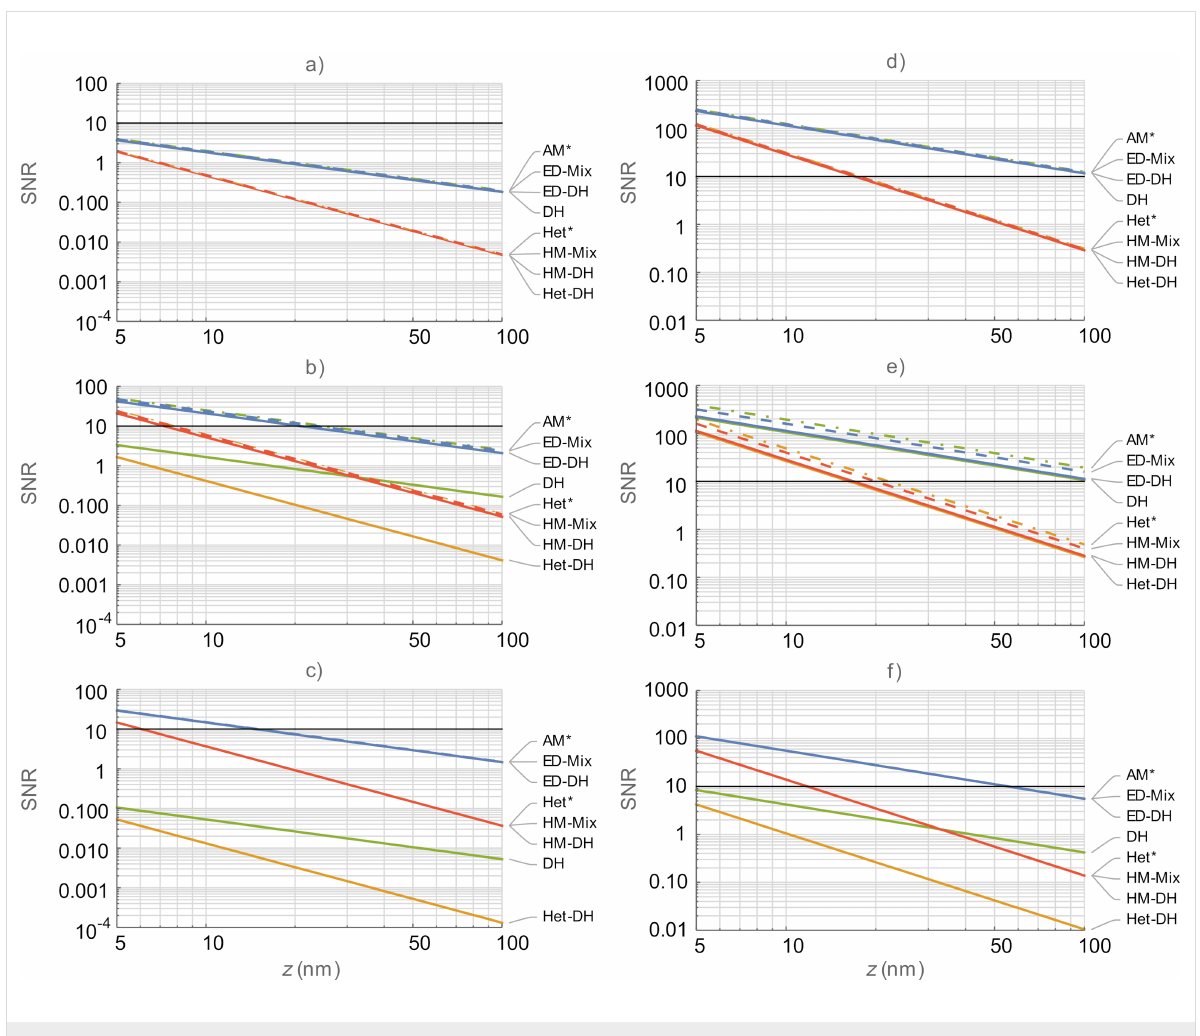
Figure 5: Comparison of SNR of KPFM modes in air (a–c) and water (d–f) for the first harmonic electrostatic response occurring on ω off (top), ω 1 (middle), and ω 2 (bottom), respectively. DH (green), Het-DH (orange), ED (blue), and HM (red). Mixed responses are shown with dashed lines. Single frequency responses are shown with dash-dotted lines. *Designated single-frequency KPFM modes. The black lines in all graphs indicate SNR = 10. Higher SNR indicated better performance for all